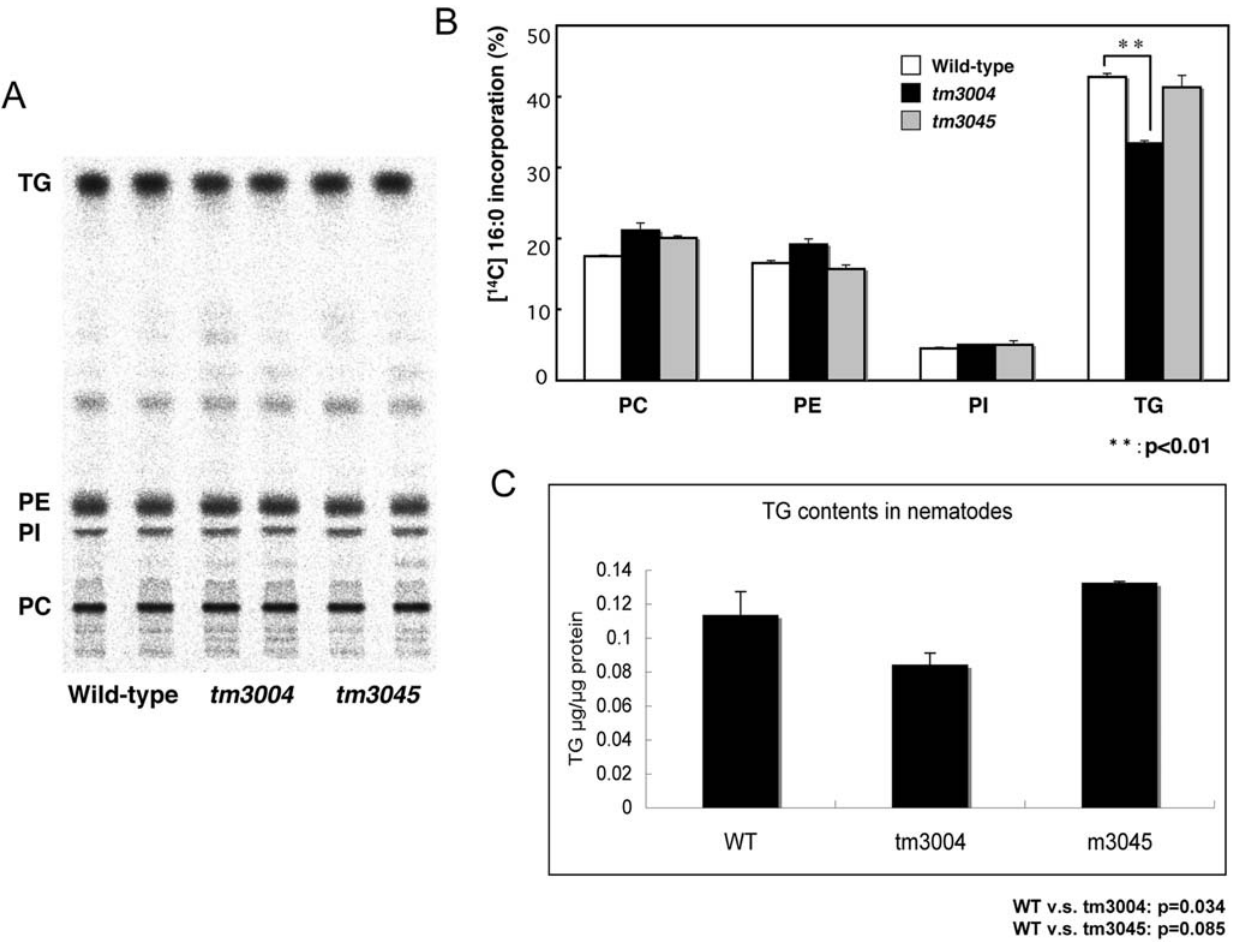
Figure 7. Abnormal lipid metabolism in the PQBP1 homologue mutant. A) Uptake of exogenous radio-labeled fatty acid (16:0) into various lipids in normal (N2), homozygous tm3004 mutant, and homozygous tm3045 mutant nematodes. TLC was exposed to for 10 hours. B) Quantitative analysis of the results in Fig. 7A. C) Triglyceride contents in nematodes.